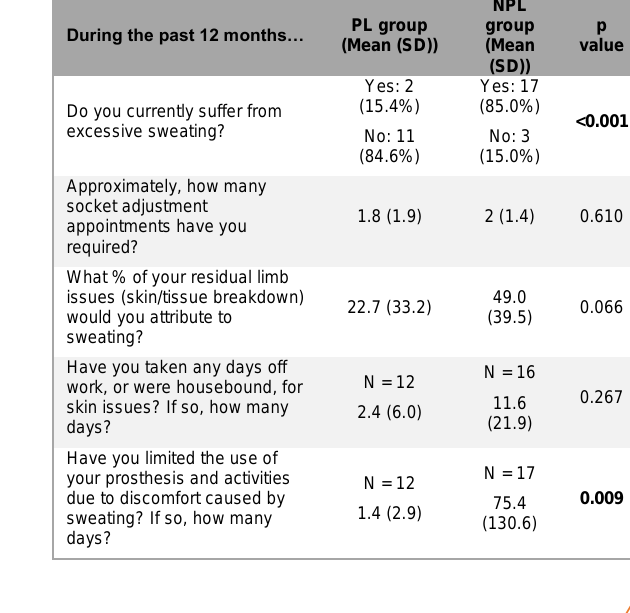
Table 3: Results of additional questions included within survey. P values in bold text indicate significance (p<0.05).